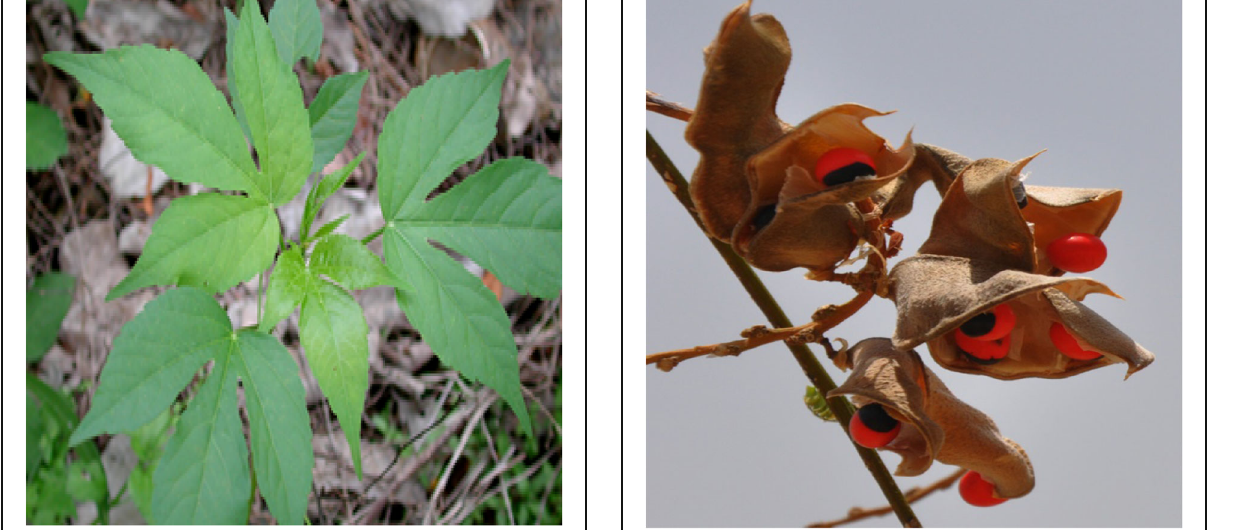
Fig. 5 Abrus precatorius . This locally common, endangered, non-